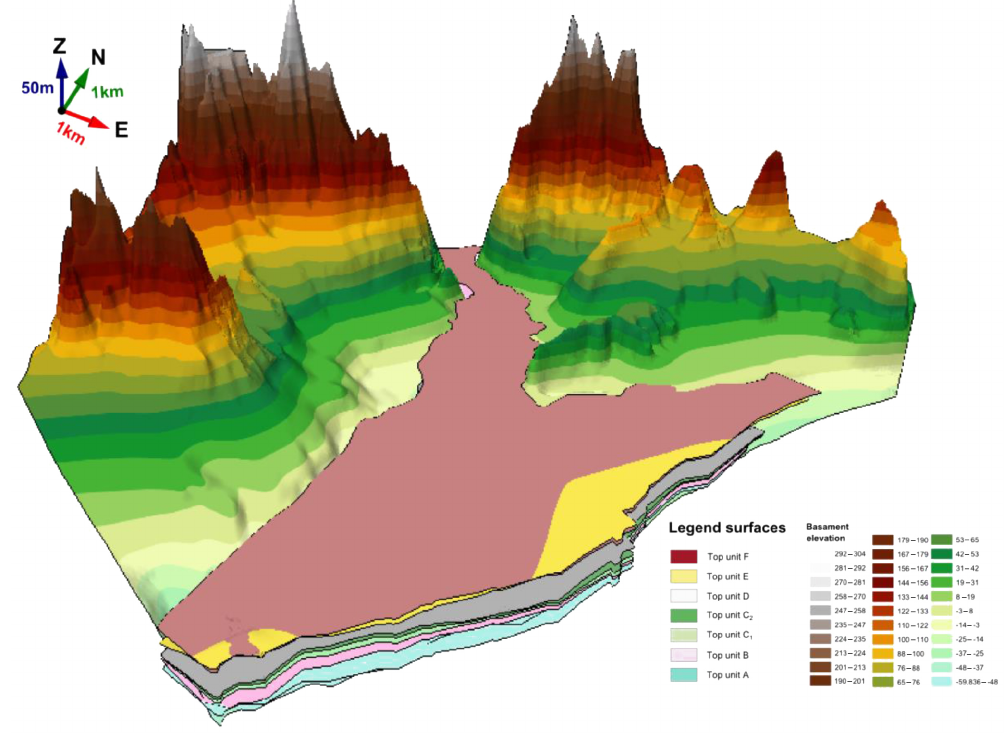
Figure 6. A 3-D model of the study area, showing the geometry of the different geological units distinguished. This model was created following the methodology proposed in this